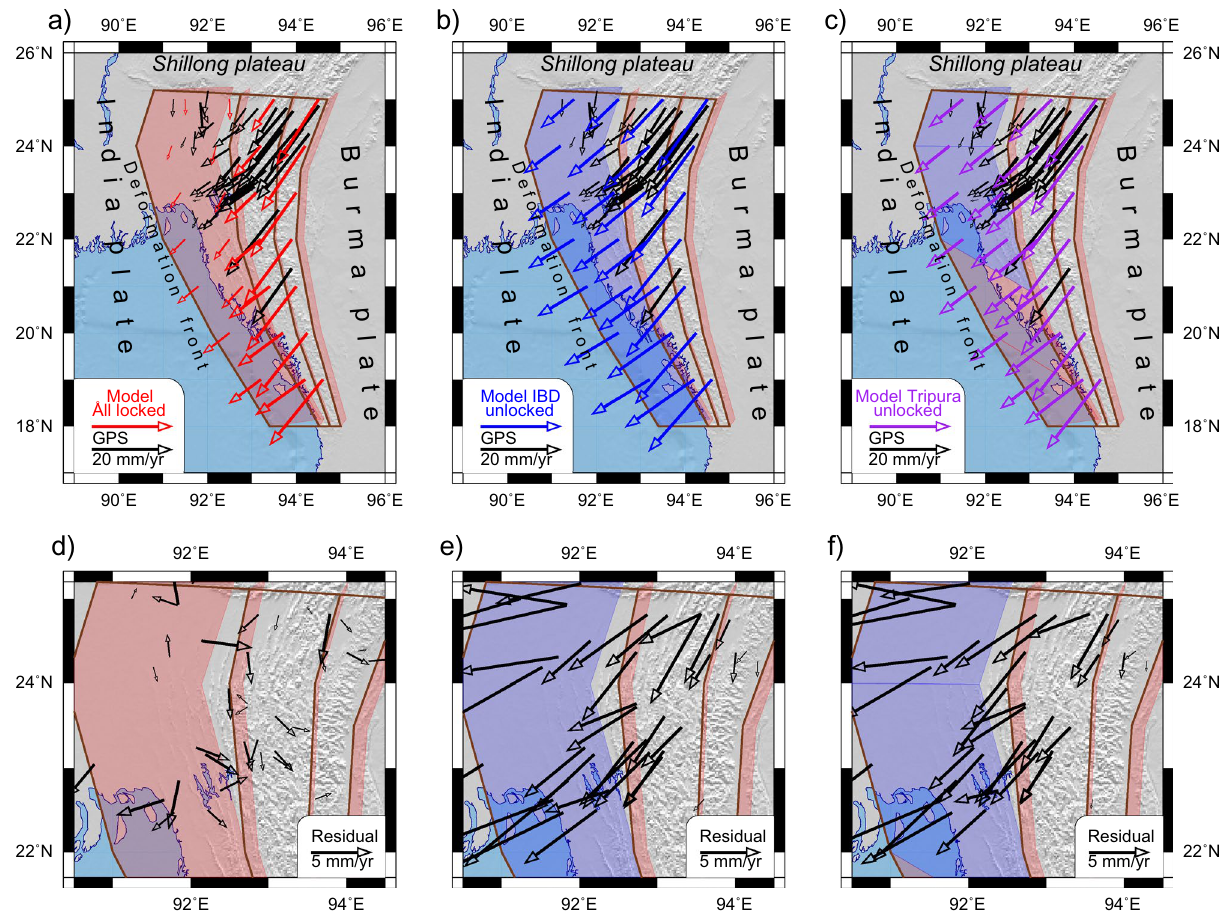
Figure 2. Block velocities modeled in three experiments. ( a ) Experiment 1 “Locked IBD” (red arrows); ( b ) Experiment 2 “Unlocked IBD” (blue arrows); ( c ) Experiment 3 “Partially locked IBD” (purple arrows). GPS velocities are shown by black arrows; locked and unlocked faults are highlighted by transparent red and blue. ( d ), ( e ) and ( f ) display the residual velocities for ( a ), ( b ) and ( c ),